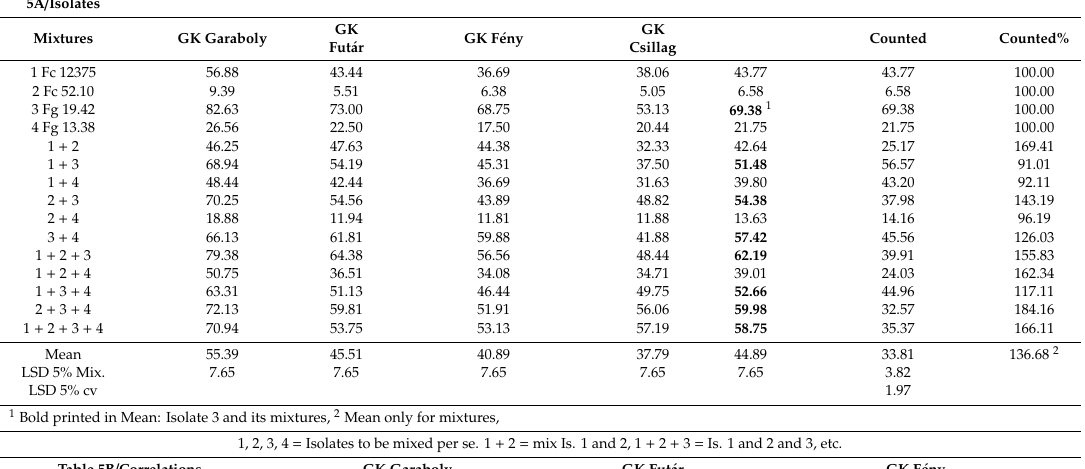
Table5B / Correlations